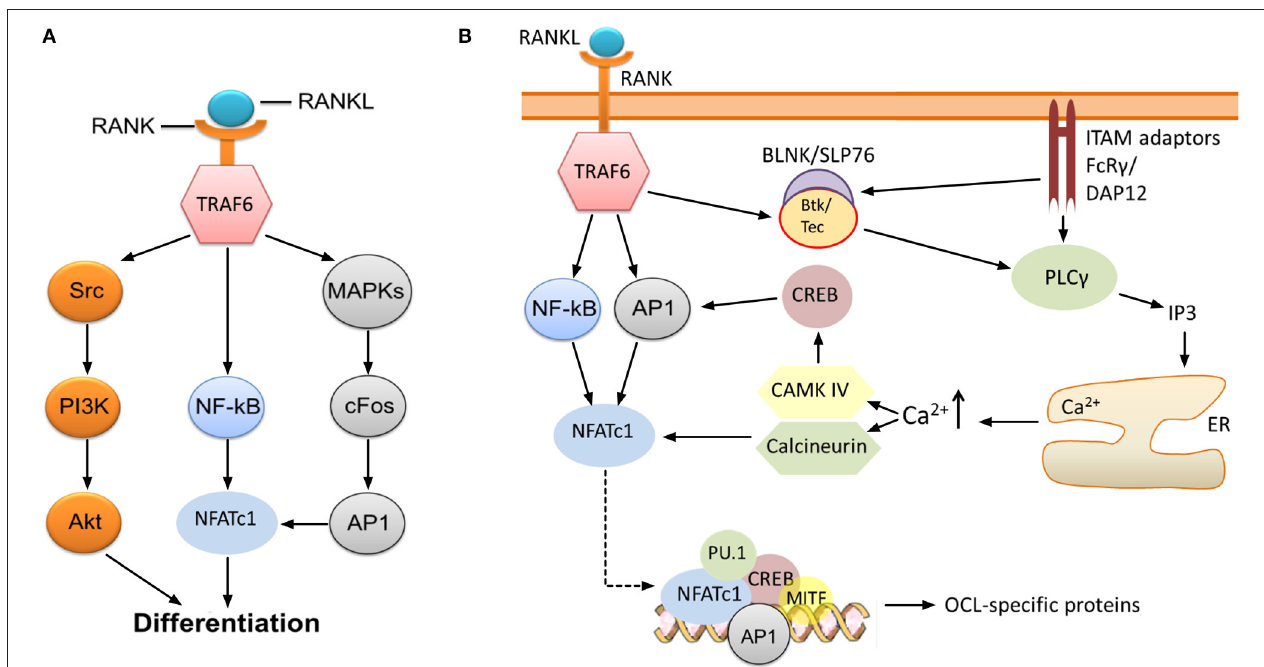
FIGURE 1 | RANK-NFATc1 signaling in OCL differentiation. (A) Binding of RANKL to RANK leads to induction of NF- κ B and AP1, which, in turn, results in increased expression of NFATc1, a key transcription factor regulating the expression of OCL-specific genes. Src-mediated activation of the PI3K/Akt pathway downstream of TRAF6 is also required for OCL production, and inhibition of these pathways impairs osteoclastogenesis. (B) Sustained induction of NFATc1 leads to expression of OCL-specific proteins. The initial induction of NFATc1 mediated by NF- κ B and AP1 is sustained through the activities of CAMK IV and the phosphatase calcineurin. This permits robust expression of NFATc1, which, together with several other transcription factors, upregulates the expression of OCL-specific genes (see text). Signaling through FcR γ and DAP12 ITAM adaptors is required for the sustained induction of NFATc1, specifically through activation of PLC γ and subsequent release of calcium from intracellular stores. Activation of PLC γ may also need phosphorylation by Btk/Tec–BLNK/SLP76 complex which is stimulated downstream of RANK/RANKL and ITAM adaptor signaling.